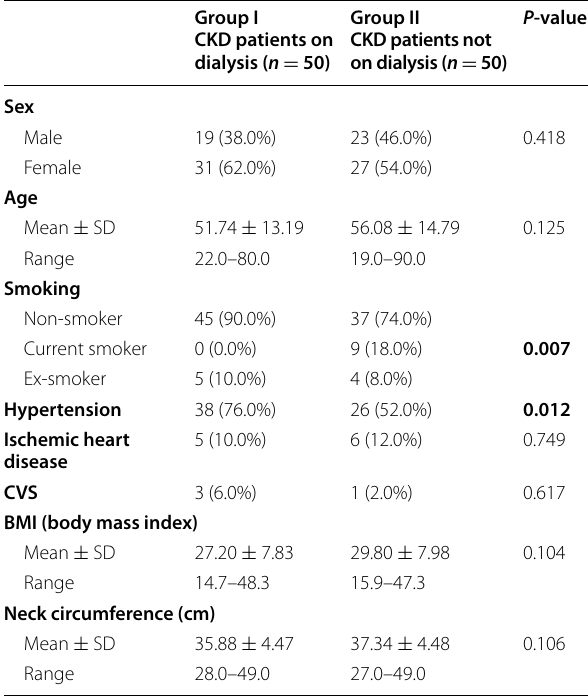
Table 1 Demographic data of both groups of chronic kidney disease